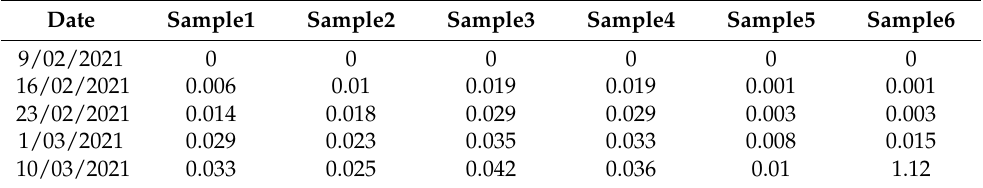
Table A5. Relative NOx production between the first row and the subsequent rows in Table A4 (mg-N L − 1